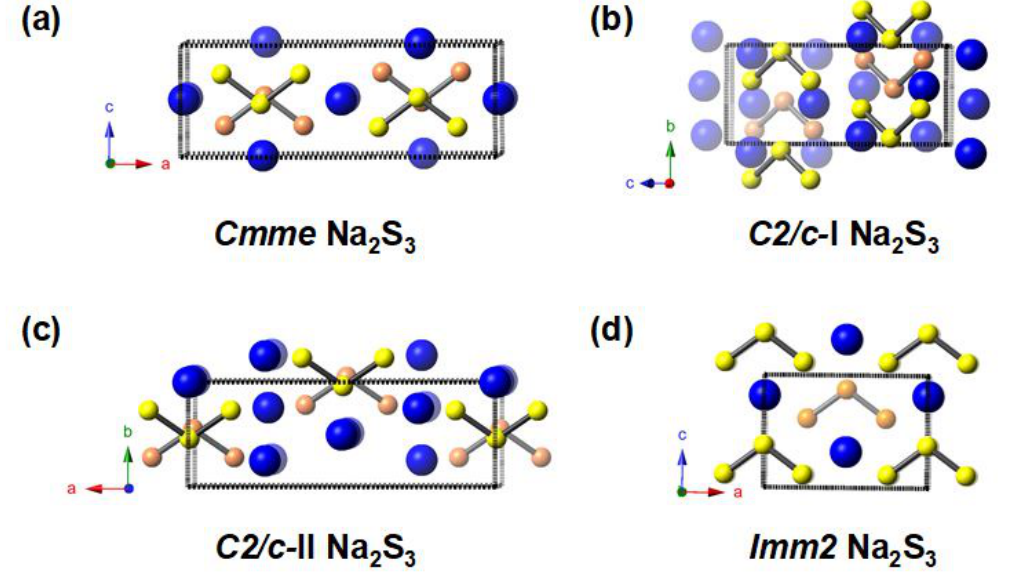
Figure 3. Unit cells of the previously predicted ( a ) Cmme -Na 2 S 3 [20], and ( b ) C 2/ c -I Na 2 S 3 [21] phases, as well as the newly found ( c ) C 2/ c -II Na 2 S 3 , and ( d ) Imm 2-Na 2 S 3 geometries. Sodium atoms are colored blue, whereas sulfur atoms in adjacent layers are yellow and orange.